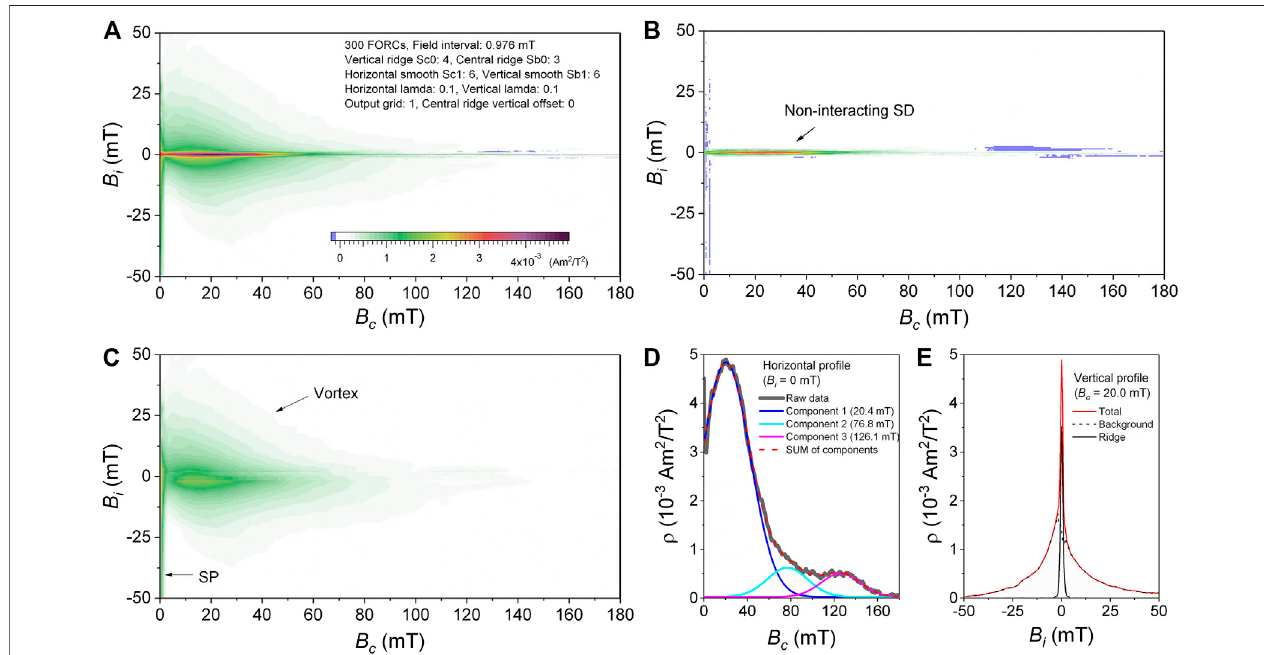
FIGURE 3 | First-order reversal curve (FORC) results. (A) FORC diagram. (B) Central ridge component extracted from the FORC diagram. (C) Background FORC componentafterremovalofthecentralridge. (D) Horizontalpro fi le ρ ( B c )oftheFORCfunction(coercivitydistributionat B i (cid:2) 0 mT).Theblacklineindicatesrawdata,while blue, cyan and purple lines indicate three components decomposed from the raw data. The dashed red line indicates a sum of all three Gaussian components. (E) Vertical pro fi les ρ ( B i ) of the FORC function (magnetostatic-interaction fi eld distribution) at 20 mT: the central ridge component (black), the background component with vertical spread (dashed black line), and the total of the two components (red line) are shown.